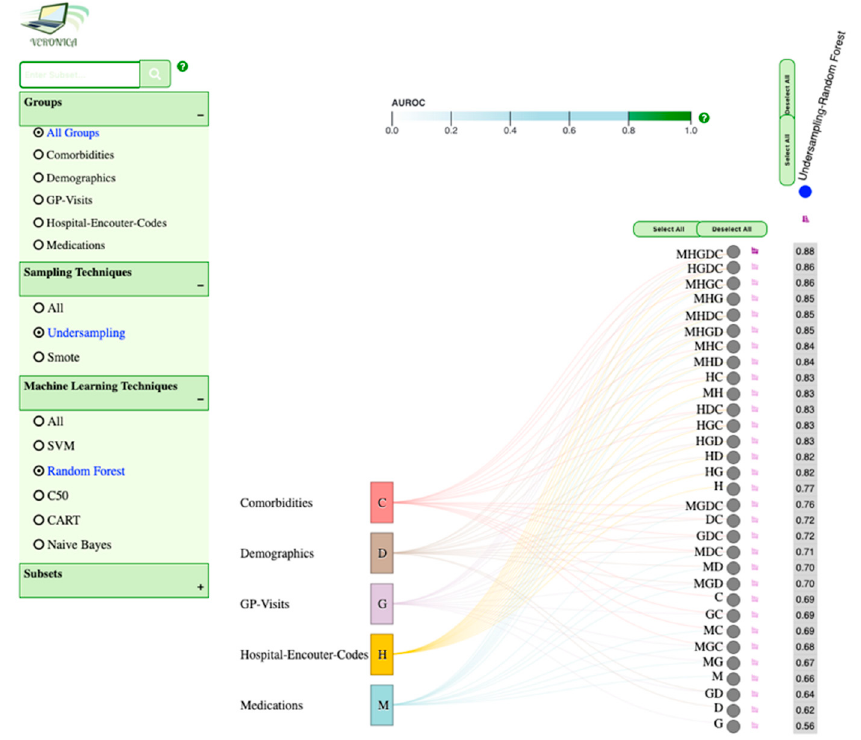
Figure 8. How the system gets updated when users select “Undersampling” and “Random Forest” from the “Sampling Techniques” and “Machine Learning Techniques” drop-down menus.